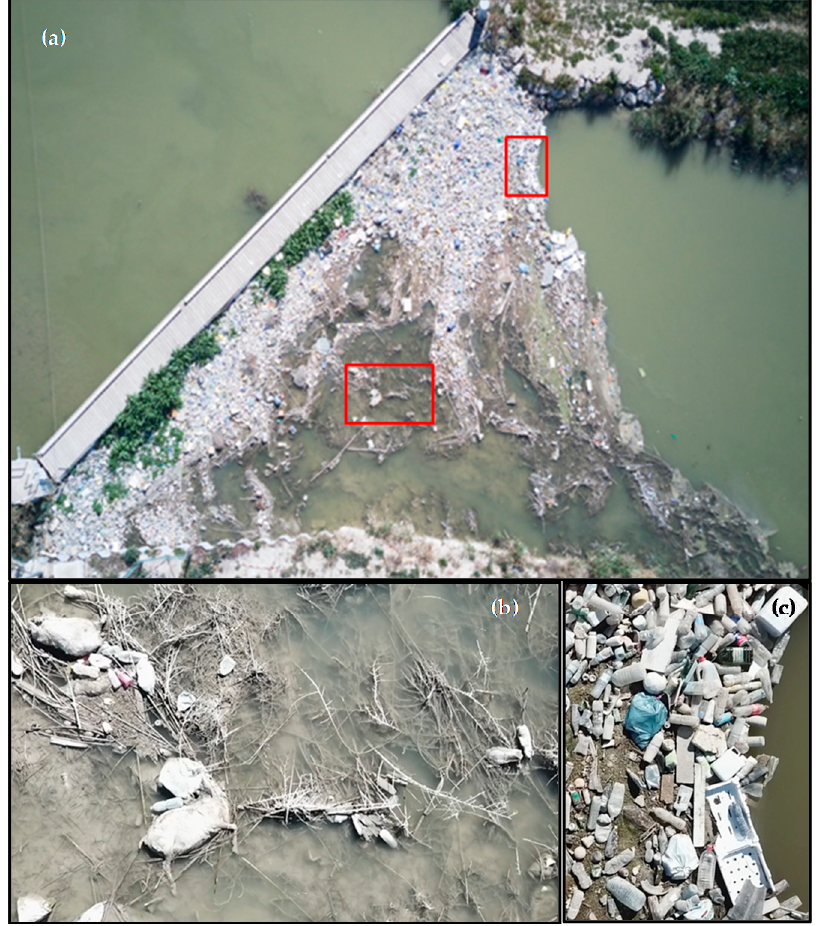
Figure 4. Zenith images captured from the drone: general ( a ) and details ( b , c ). Measurements were taken on 22 January, 25 February, 8 April, 6 May, and 1 July 2019. The dates were influenced by the authorities issuing flight